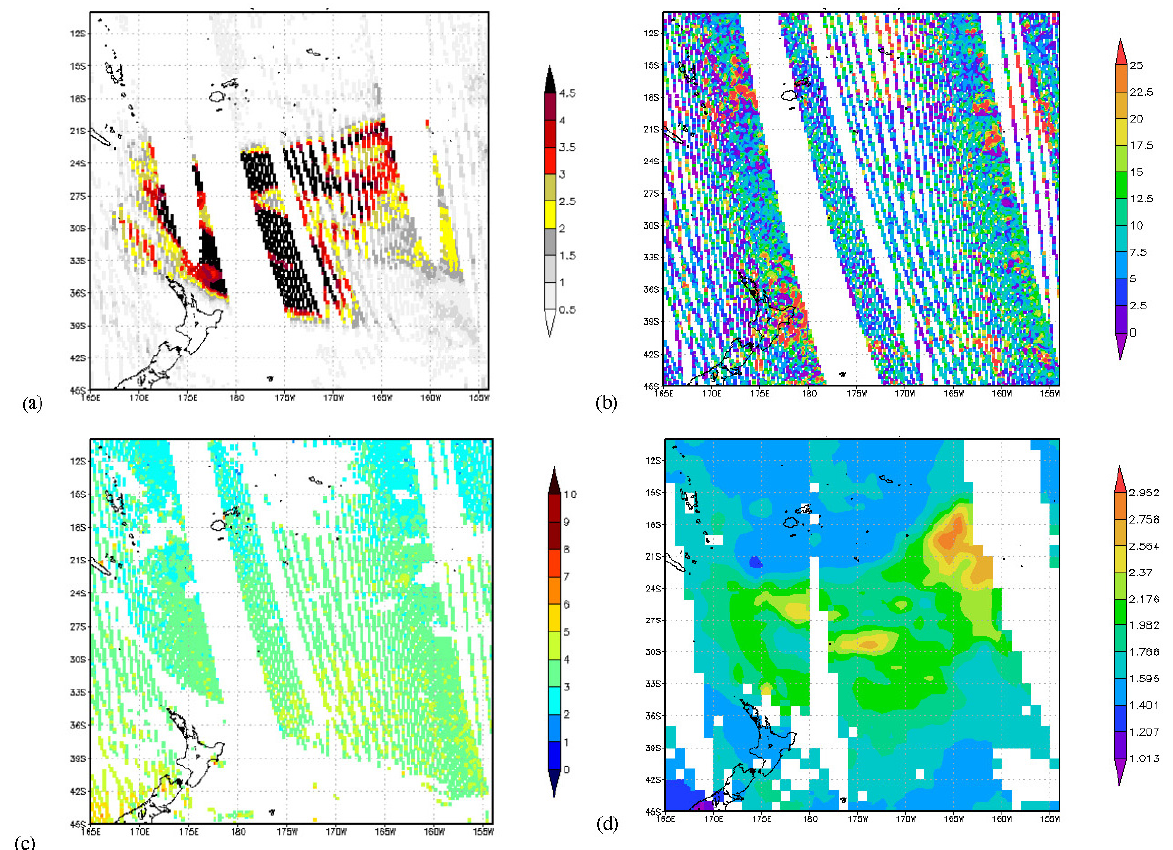
Figure 4. Images representing the travelling plume from Black Saturday from 10°S, 165°E to 45°S, 156°W on 10 February 2009 using (a) OMI UV aerosol index, (b) OMI H total column amount (×10 15 molecules.cm − 2 ), (c) OMI NO molecules.cm − 2 ) and (d) AIRS CO total column amount (×10 18 molecules.cm − 2